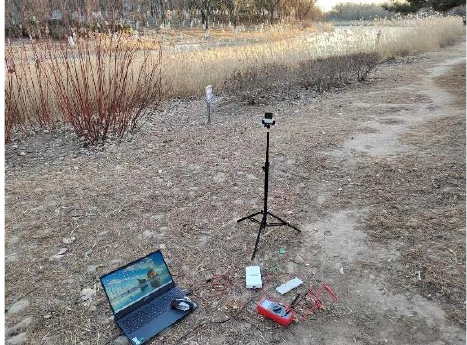
Figure 11. Experimental setup for scattered solar radiation experiment.